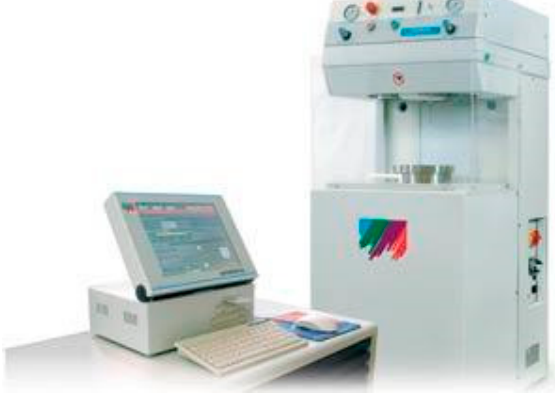
Figure 11. Subcritical water extraction of proteins from rapeseed cake.